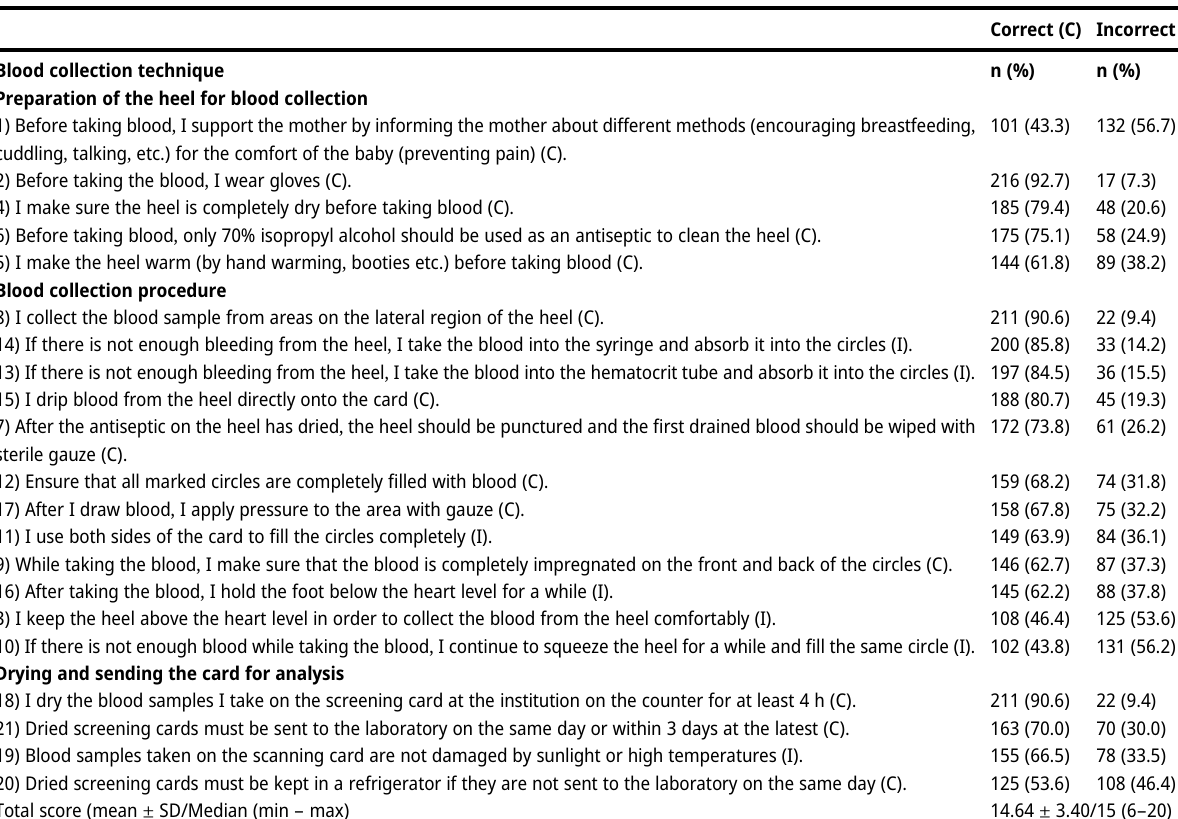
Correct (C) Incorrect (I)